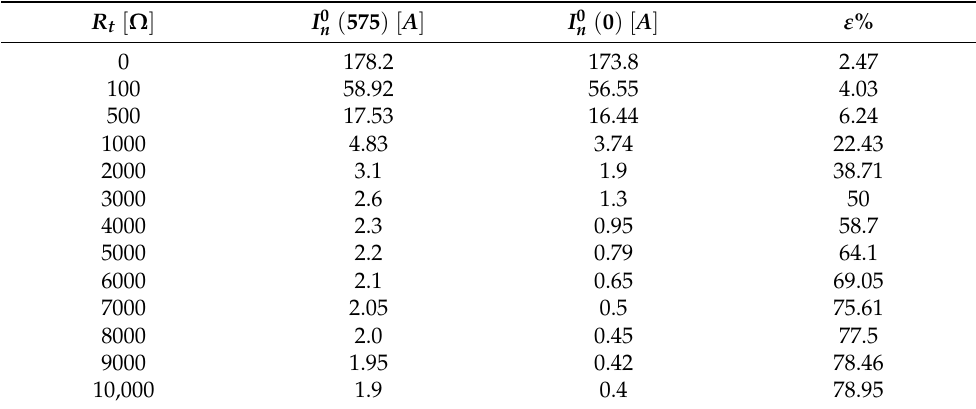
Table 3. The insulation of medium voltage network is perfect ( tan δ = 0 ) .